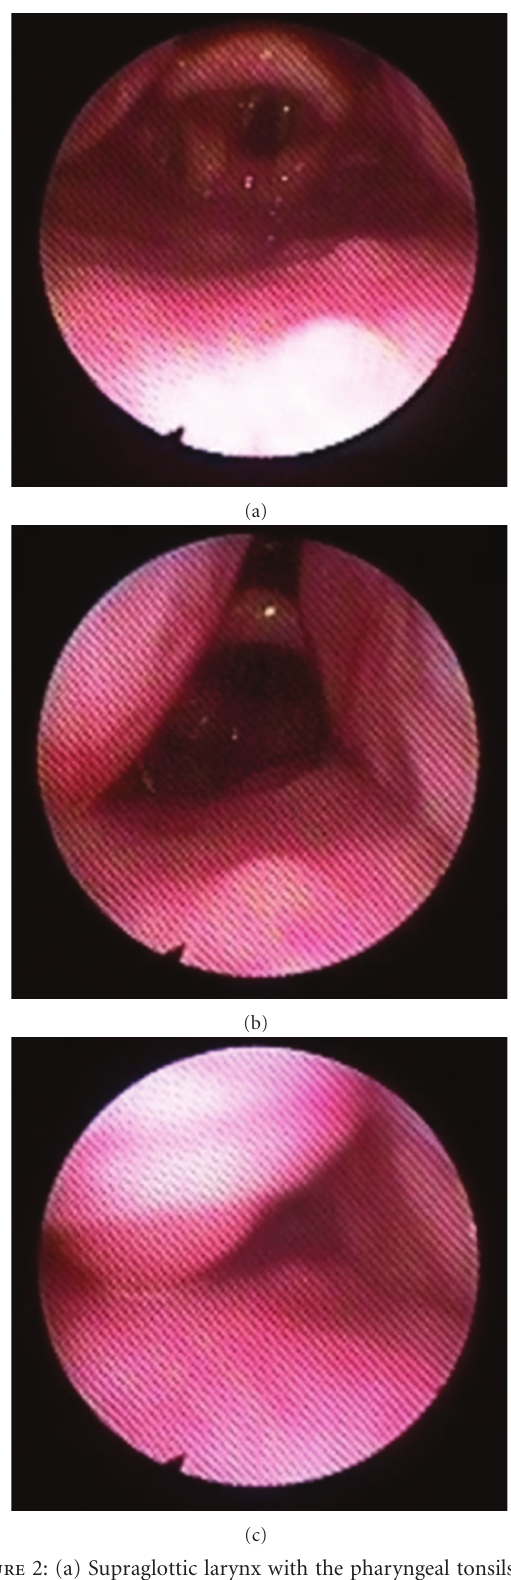
Figure 2: (a) Supraglottic larynx with the pharyngeal tonsils seen laterally. (b) Rapid collapse of the pharyngeal tonsils medially on inspiration. (c) Complete obstruction of the airway by the pharyn- geal tonsils on inspiration. On the expiration, the tonsils returned to their normal positions as in Figure 2(a).